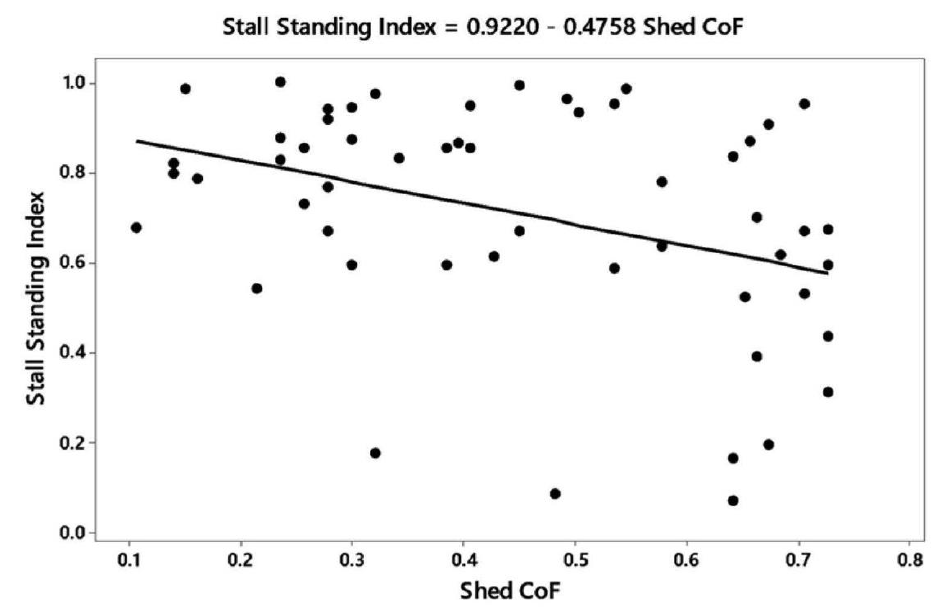
Figure 2. Relationship between the proportion of cows standing (stall standing index) and coefficient of friction (CoF) of shed floor.